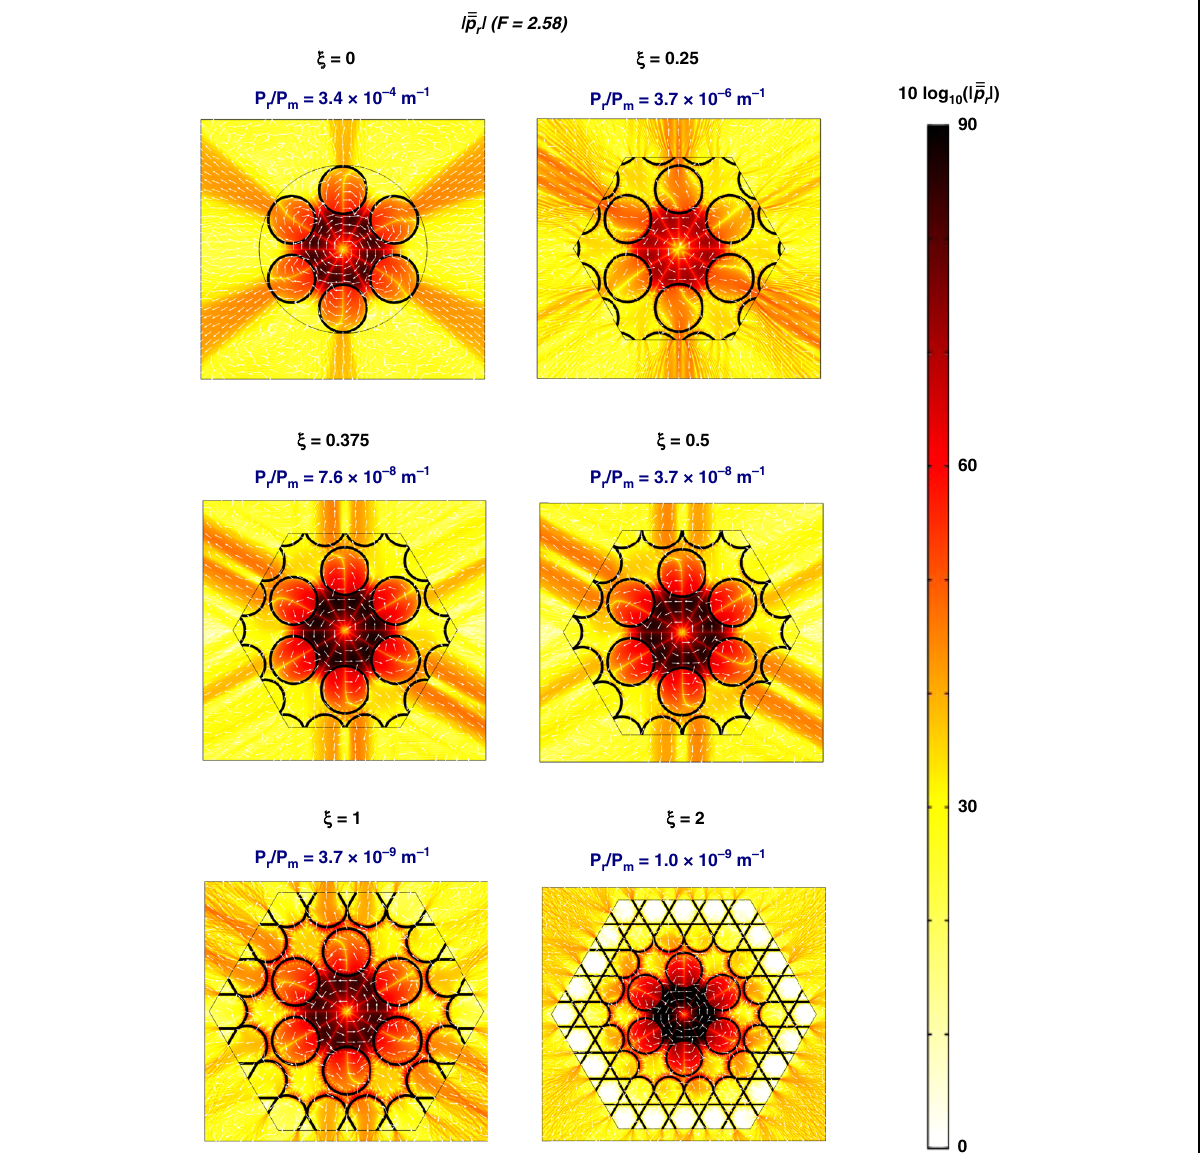
Fig. 3 Modulus of the normalised radial component of the Poynting vector for representative values of ξ at F = 2.58, and the respective P = P r m values. Adding the Kagome structure around the tubes that form the tubular lattice allows minimising the strength of the leaking channels of the structure. The colour scale refers to 10 log